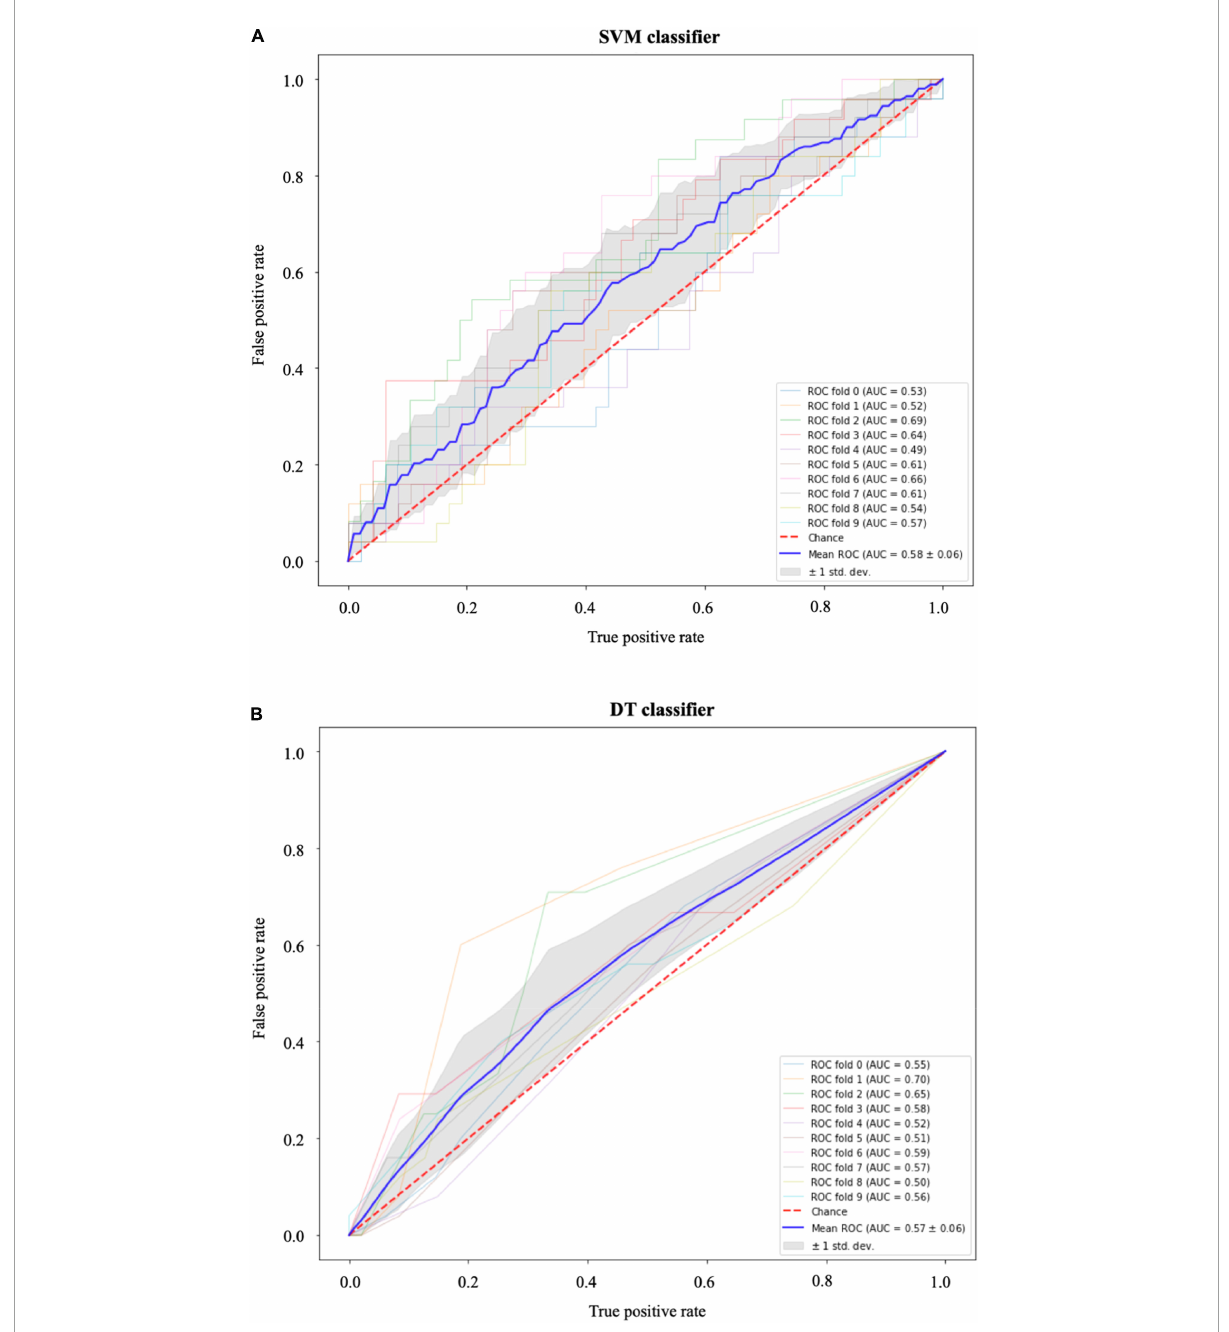
FIGURE9 Receiver operating characteristic (ROC) curves for (A) the support vector machines (SVM) and (B) the decision tree (DT) classifiers. In both models, the area under the curve (AUC) values (0.5 < AUC < 1) show that the classifiers have some predictive power above “chance” to distinguish between the positive class values from the negative class values. The gray area indicates ± 1 SD calculated from 10-fold